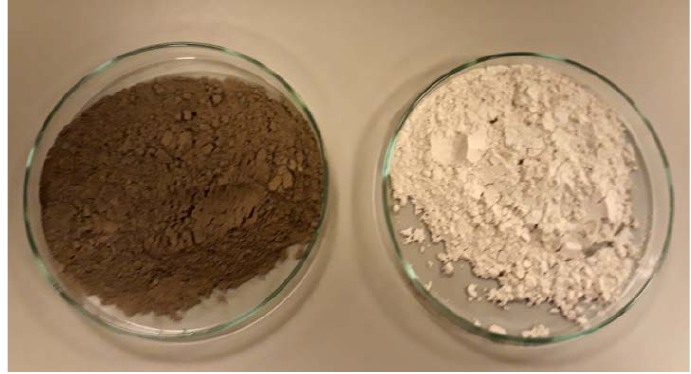
Fig. 2 The raw waste materials, fly ash and